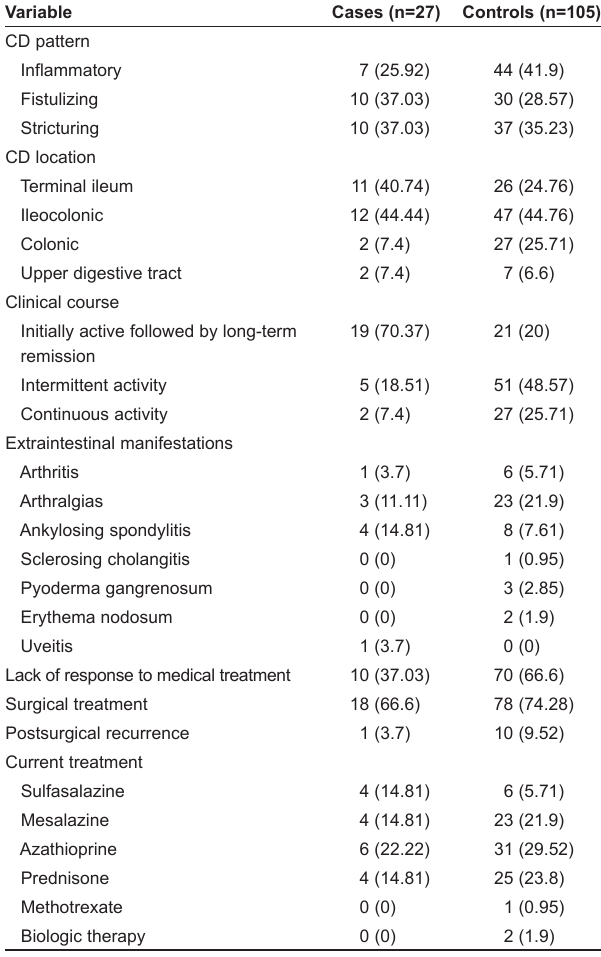
Table 1 Demographic variables of patients with Crohn disease